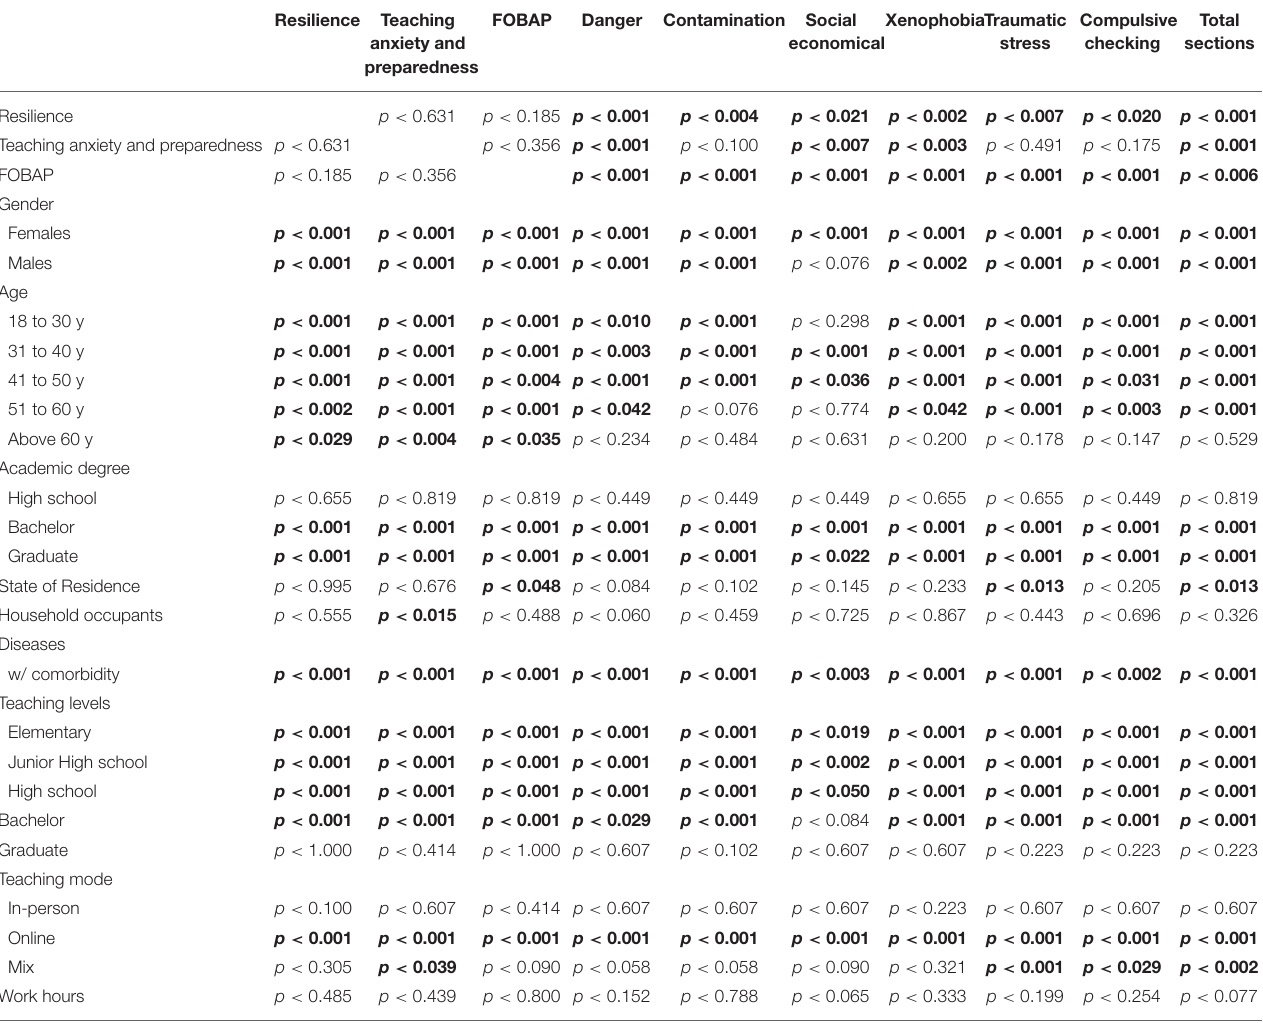
TABLE 4 | Statistical correlations of all variables: resilience, teaching anxiety and preparedness, FOBAP, Sociodemographic profiles, ACSS and Total